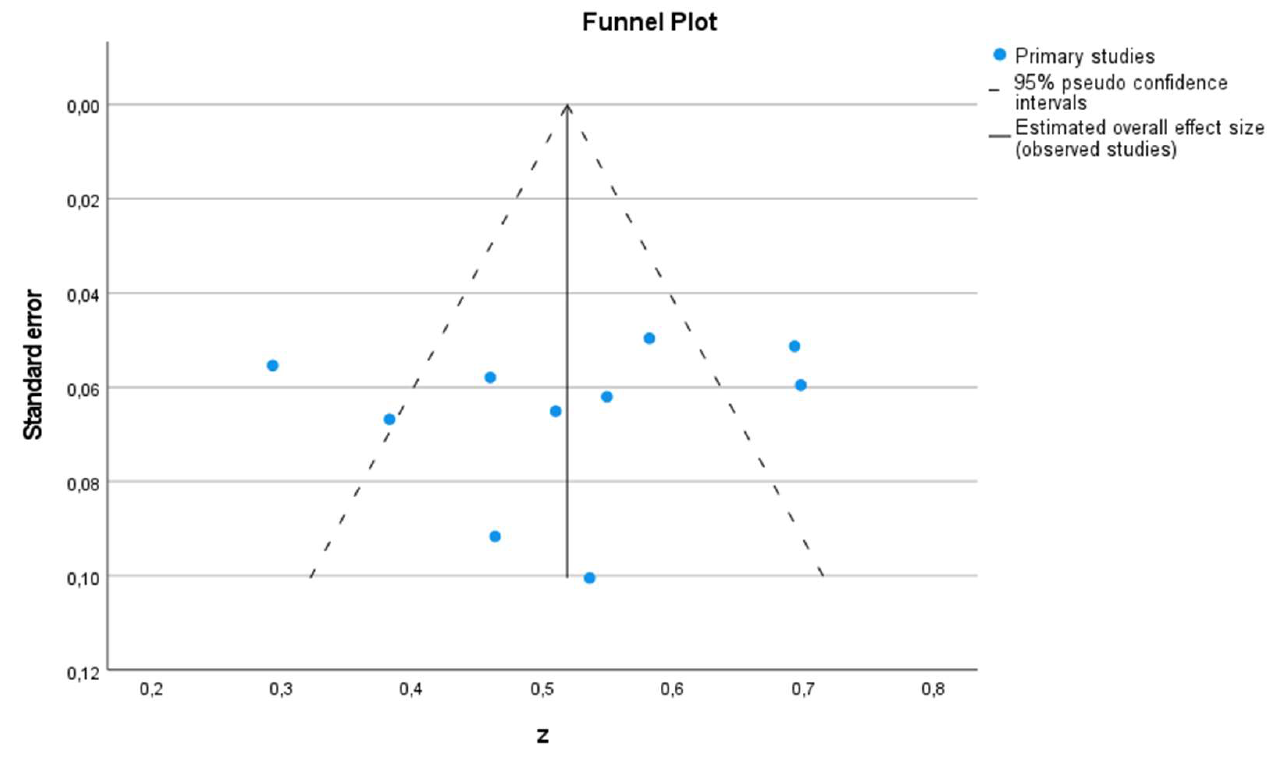
Figure 16. Funnel Plot for Correlation Data.